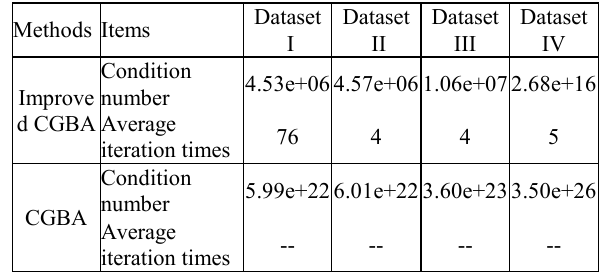
Table 3. Experimental results of improved CGBA and